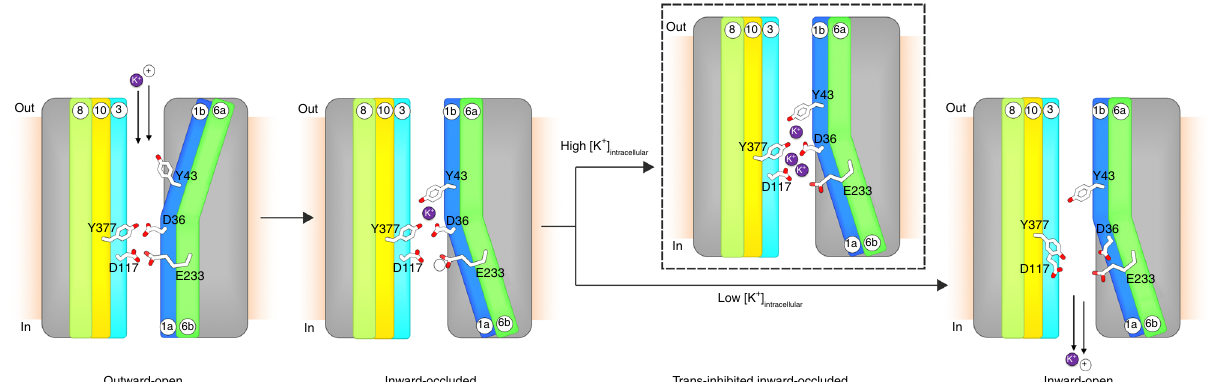
Fig. 6 Schematic representation of alternating access transport in KimA. The outward-open conformation should provide access of protons and potassium ions from the extracellular side to the binding sites, while at the cytoplasmic side the exit tunnel should be tightly sealed. The binding of a proton and a potassium ion could result in the movement of Y43, which serves as external gate occluding the bound substrate. Subsequently, broken helices TM1 and TM6 could alternate, sealing the extracellular tunnel and opening the intracellular tunnel. A thin, intracellular gate formed by residues D36 and Y377 could yet sustain an occluded state. Upon deprotonation of E233, the intracellular gate could open, allowing potassium ion release to the cytoplasm. At high intracellular potassium concentrations, potassium ions could bind within the intracellular tunnel preventing the opening of the intracellular gate. We hypothesize that our cryo-EM structure represents such a trans-inhibited, inward-occluded state (highlighted with dashed